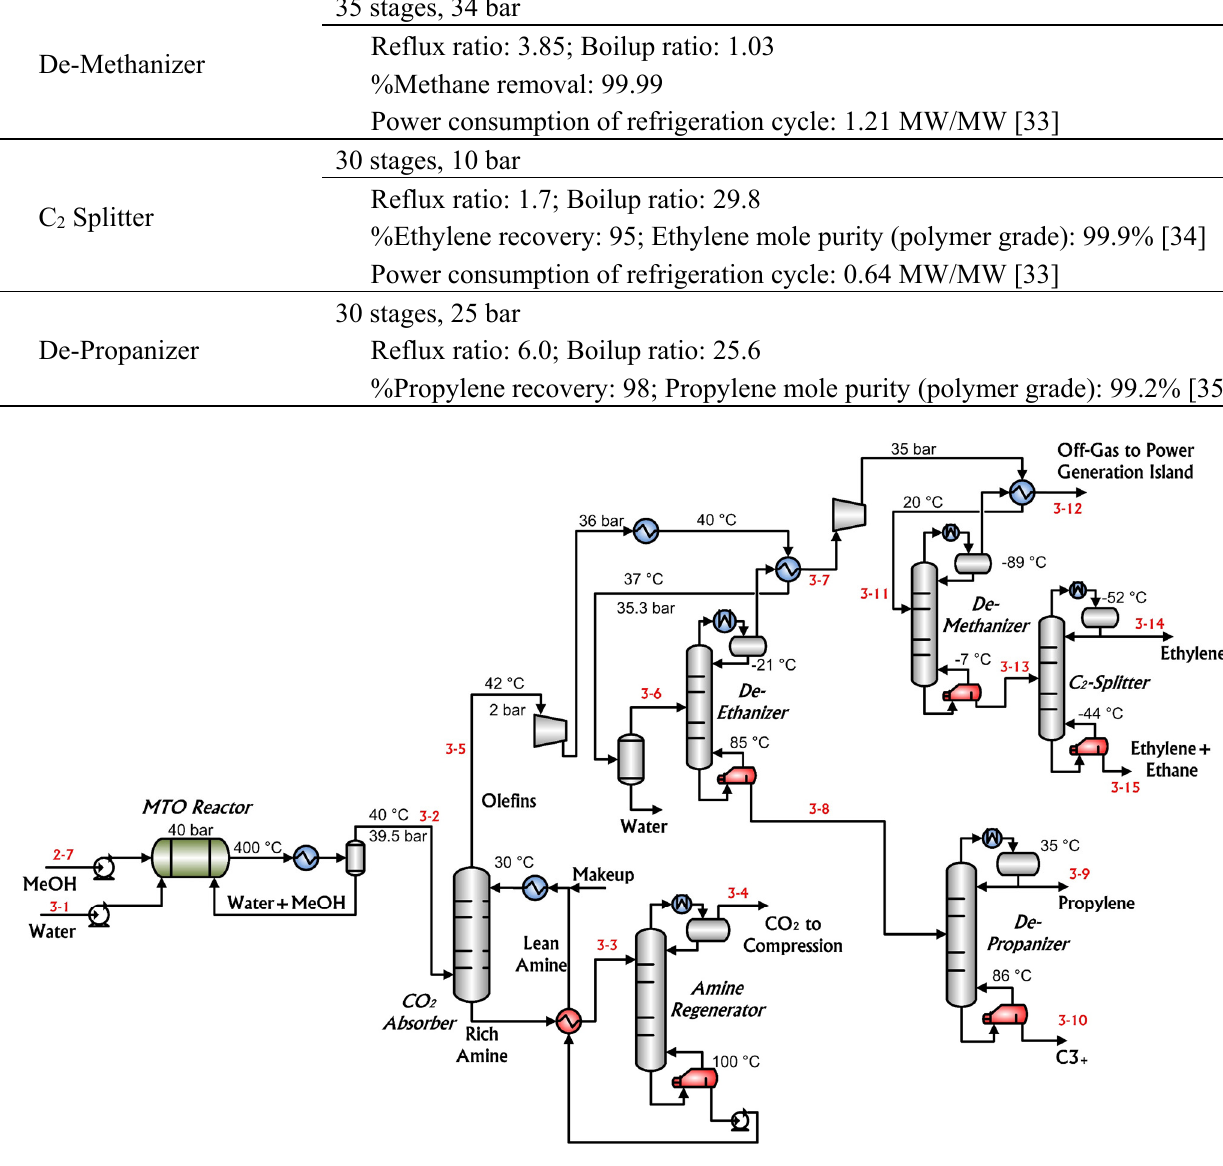
Figure 4. Section 3: Methanol-to-olefins process (MTO) based on UOP/Hydro technology